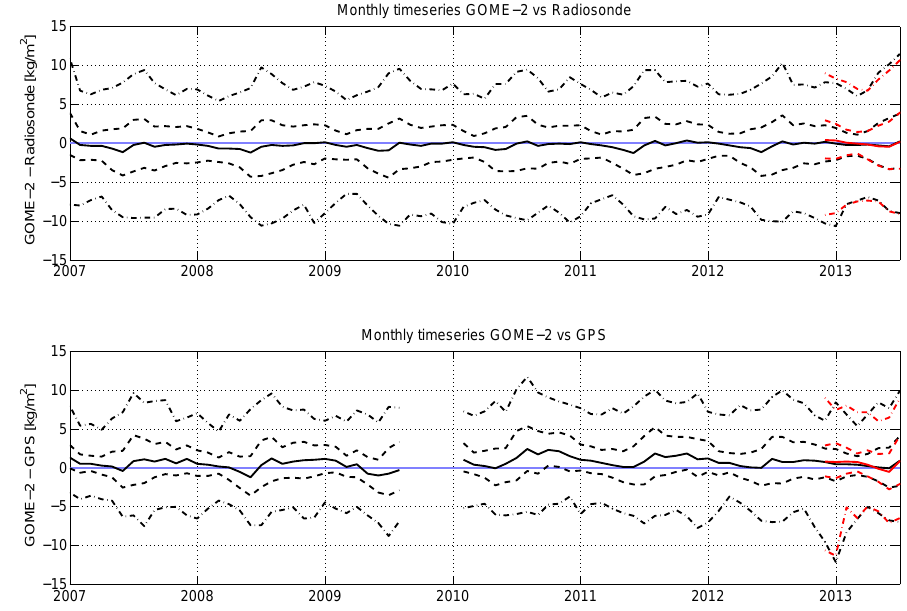
Figure 4. Time series of global monthly median differences (solid line), 25 and 75% percentiles (dashed lines) and 5 and 95% percentiles (dash-dot lines) for GOME-2A (black) and GOME-2B (red) against radiosonde (top) and GPS